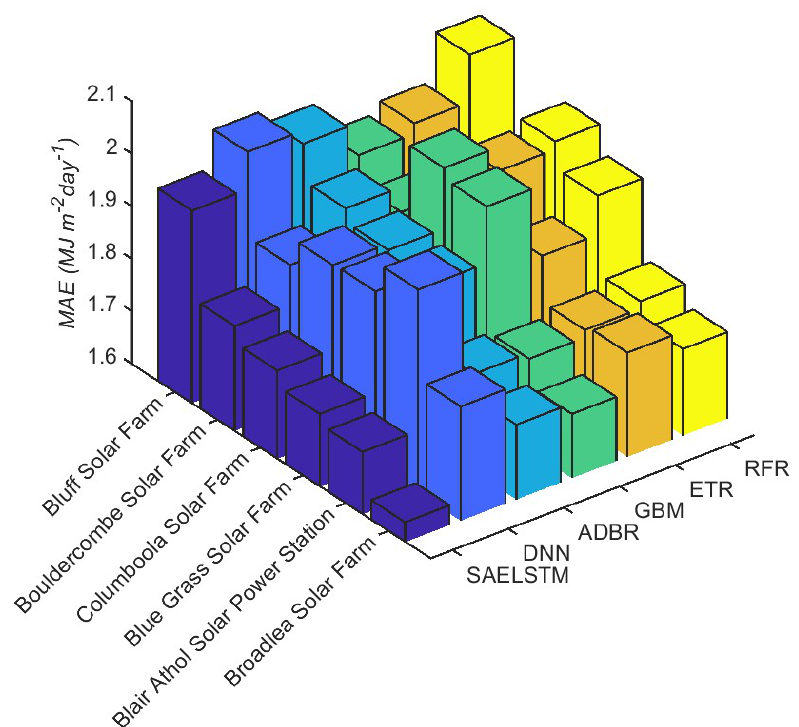
Figure 7. Evaluation of the newly proposed SAELSTM hybrid predictive model with respect to the counterpart comparison models as measured by the mean absolute error ( MAE , MJm − 2 day − 1 ) in the testing phase. (Note: names for each model are provided in Tables 3 and 4.) Table 4. The performance of the proposed deep learning hybrid SAELSTM vs. counterpart compari- in the model’s testing